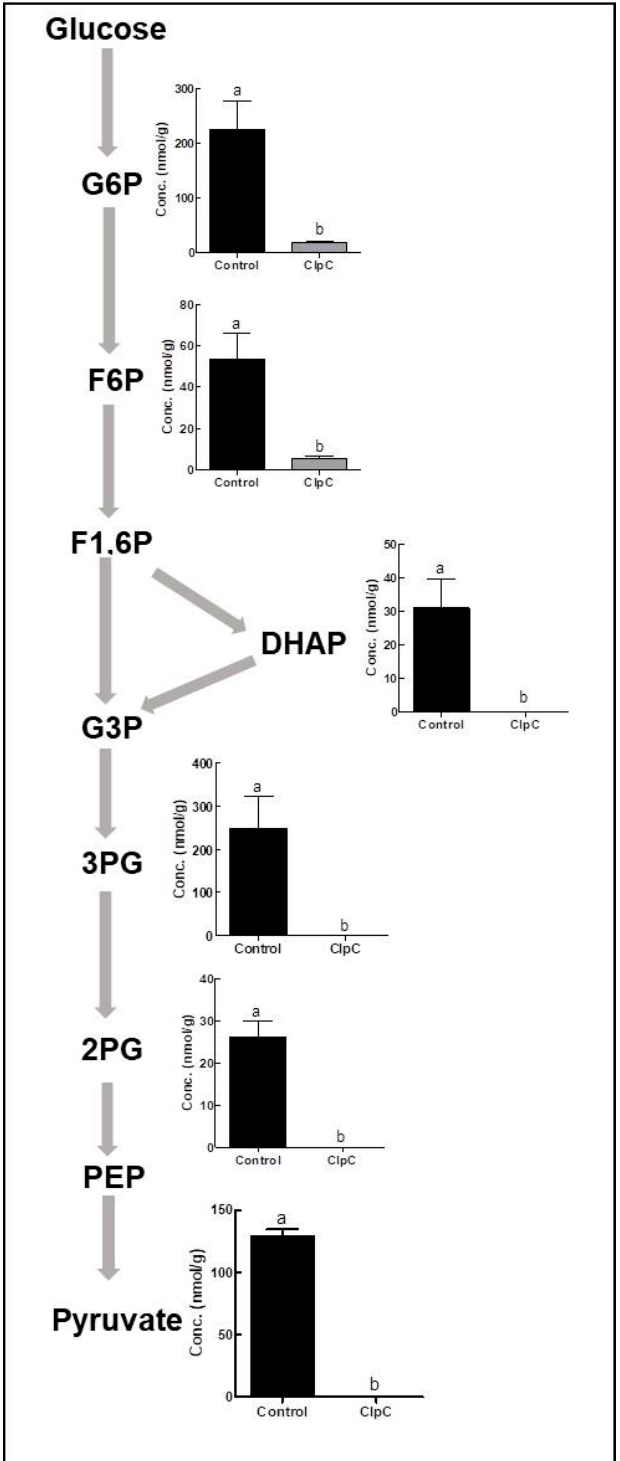
Figure 2. Comparison of glycolysis metabolite contents between control and NbClpC1 / C2 co-suppressed Nicotiana benthamiana plants. G6P, glucose-6-phosphate; F6P, fructose-6-phosphate; F1,6P, fructose-1,6-bisphosphate; G3P, glyceraldehyde-3-phosphate; DHAP, dihydroxyacetone phosphate; 3PG, 3-phosphoglyceric acid; 2PG, 2-phosphoglyceric acid; PEP, phosphoenolpyruvate. The error bars indicate the standard deviation (SD) of triplicate samples. The di ff erent letters on the bars indicate statistically significant di ff erences between groups ( p <